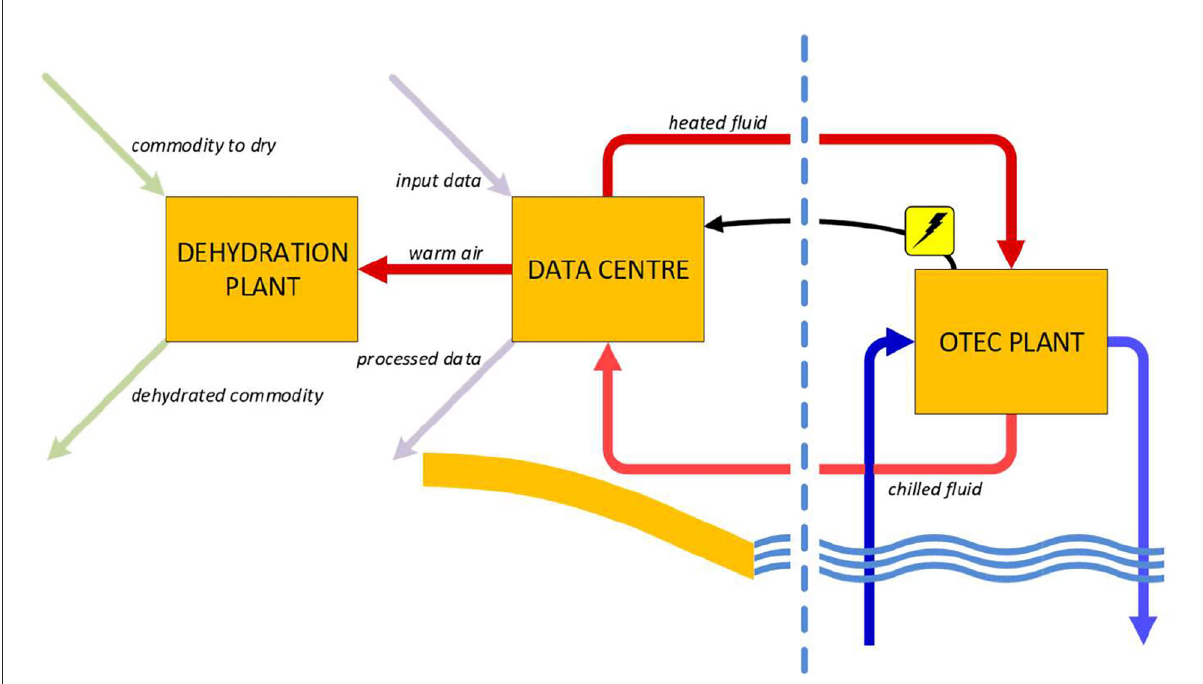
FIGURE5 A tropical large-scale data center, and its industrial symbiosis with an OTEC plant and a dehydration